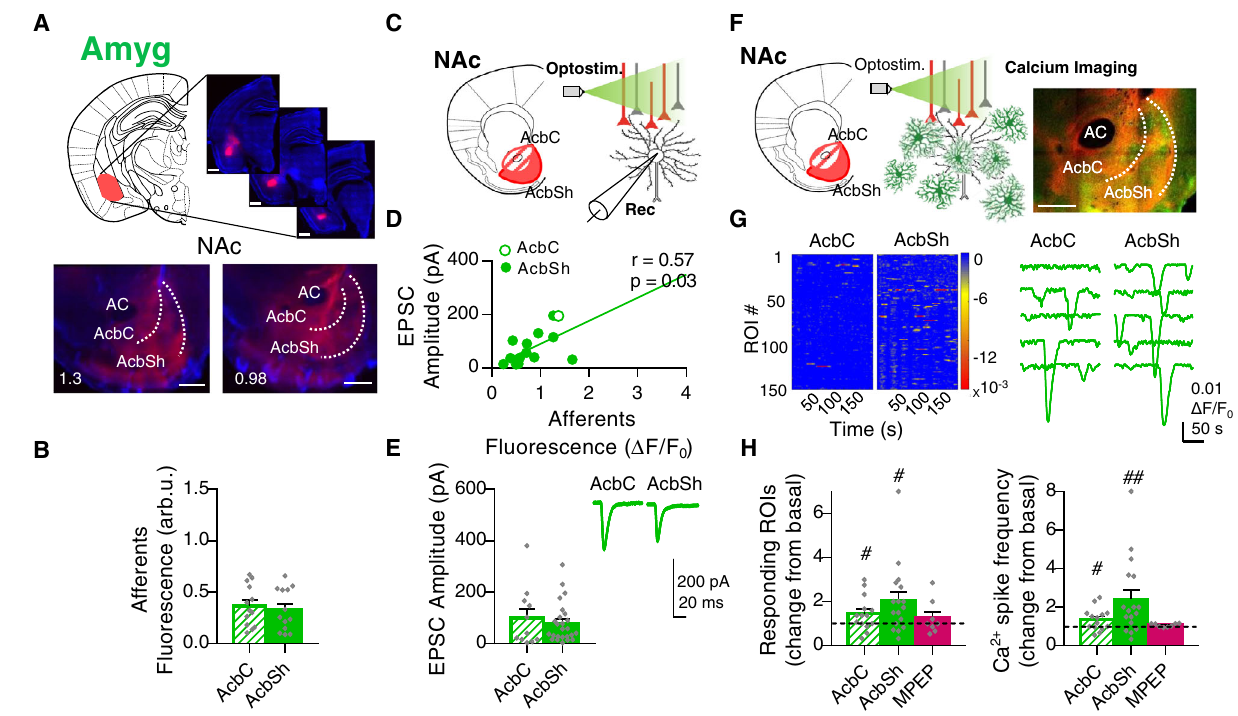
Fig. 4 | Pathway-speci fi c nucleus accumbens (NAc) astrocyte activity in response to basolateral amygdala (Amyg) afferents. A Scheme and representa- tive slices showing opsin expression (ChrimsonR-tdTom) after AAV injection into the Amyg (top; scale bar = 1mm) and their tdTom-expressing afferents to the NAc (bottom; scale bar=500 µ m). B Quanti fi cation of Amyg afferents fl uorescence (arb.u.) in accumbens core (AcbC; slashed bar) and accumbens shell (AcbSh; solid bar) (13 infections, 7 mice). Two-tailed unpaired t test Welch-corrected, P =0.63. C Scheme of NAc neuron ’ s electrophysiological recordings in response to Amyg afferent ’ s optostimulation. D Positive correlation between NAc neuron ’ s response (pA) and Amyg afferents ’ density ( Δ F/F 0 in the area of register) (15 cells, 2 mice). E EPSCamplitude(pA)quanti fi cation(left)fromAcbC(slashedbar;11cells,3mice) and AcbSh neurons (solid bar; 25 cells, 2 mice), and representative EPSCs traces (right) showing the synaptic neuronal strength triggered by Amyg in each sub- region. Two-tailed unpaired t test, P =0.54. F Scheme of astrocytic Ca 2+ dynamics